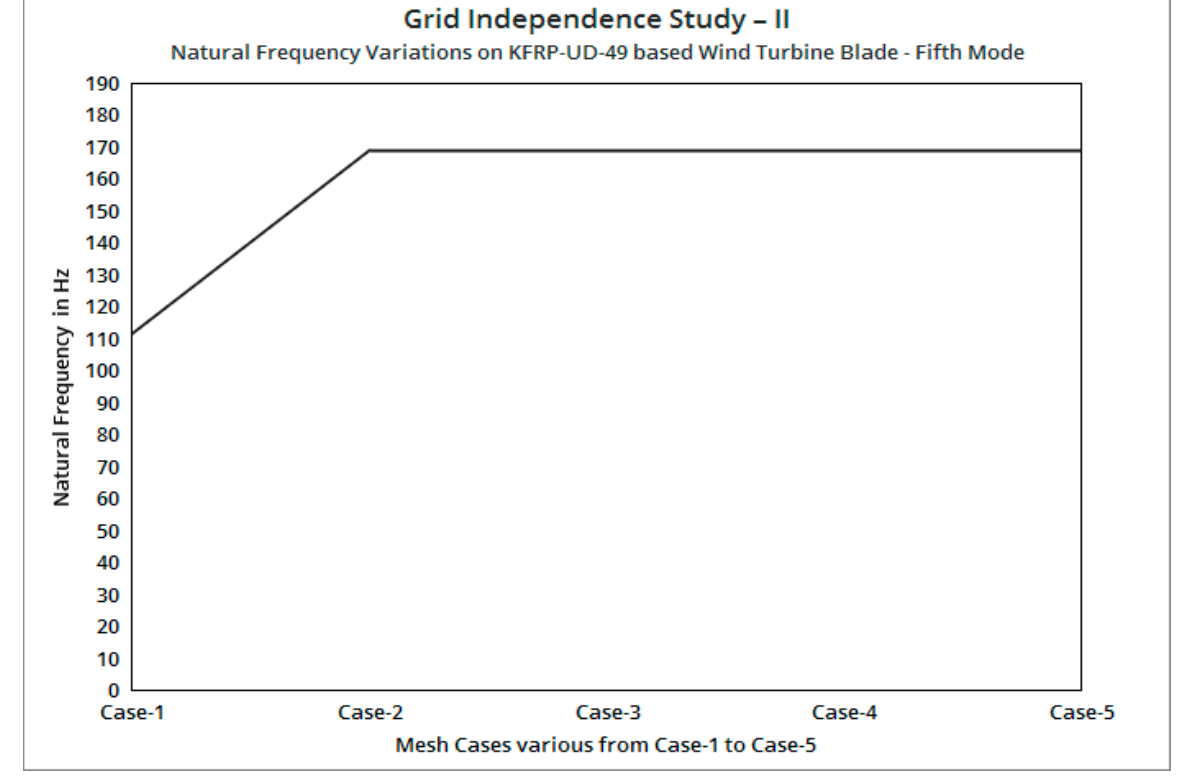
Figure 12. Grid convergence test1 (aerodynamic pressure on UAV-wing in kPa).